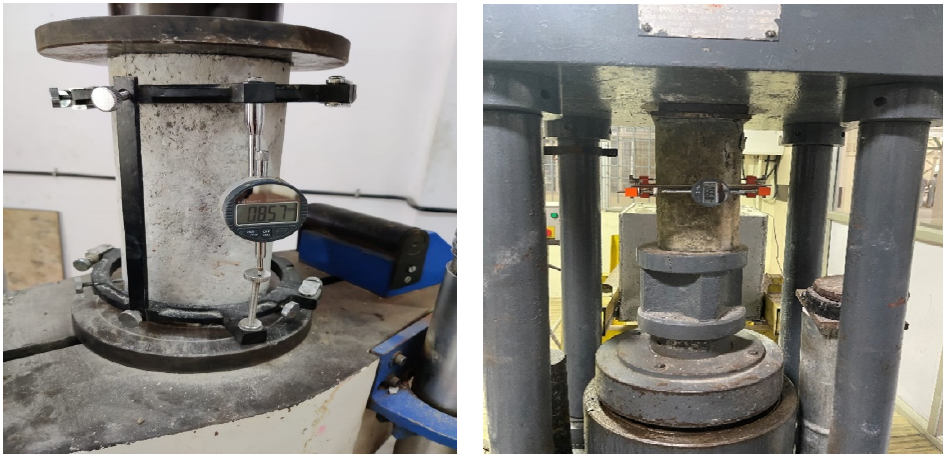
Figure 8. Compressometer test for lateral strain and linear strain measurements.